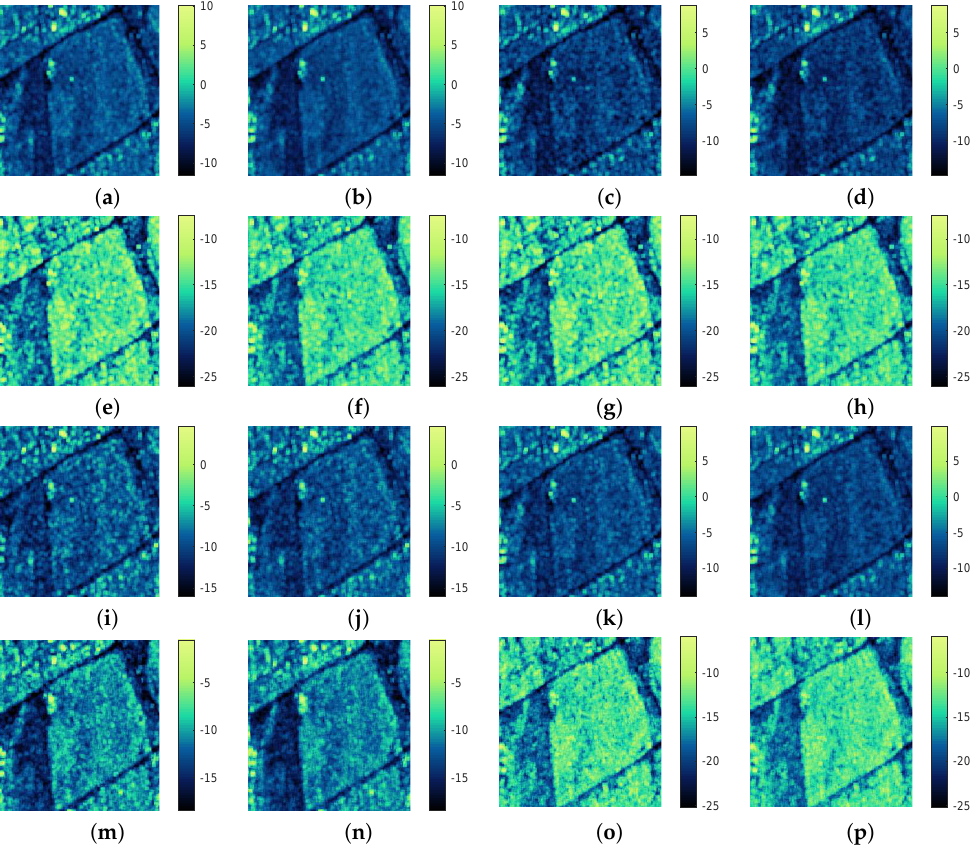
Figure 12. Boxcar 5 5 filtered polarimetric parameters for Subset 2 of Figure 8. (+,+): original data, × decorrelated data. ( a , b ): SPAN; ( c , d ): σ hh ; ( e , f ): σ hv ; ( g , h ): σ vh ; ( i , j ): σ vv ; ( k , l ): λ 1 ; ( m , n ): λ 2 ; ( o , p ): λ 3 . All features are shown in logarithmic scale